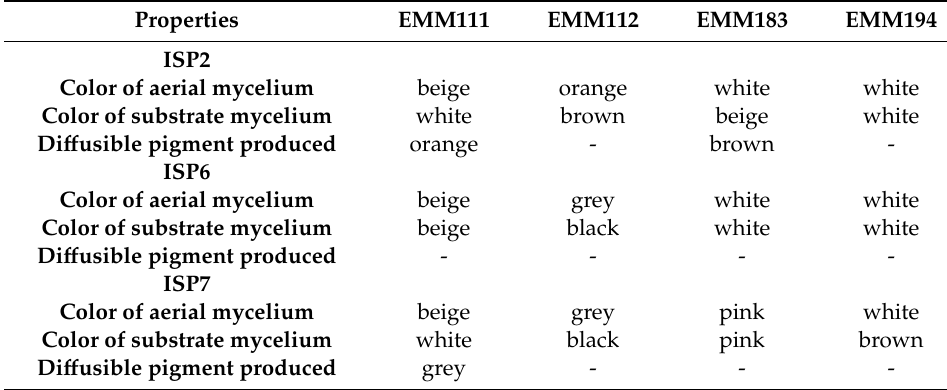
Table 3. Morphological and physiological characteristics of four selected predatory Actinobacteria isolates.